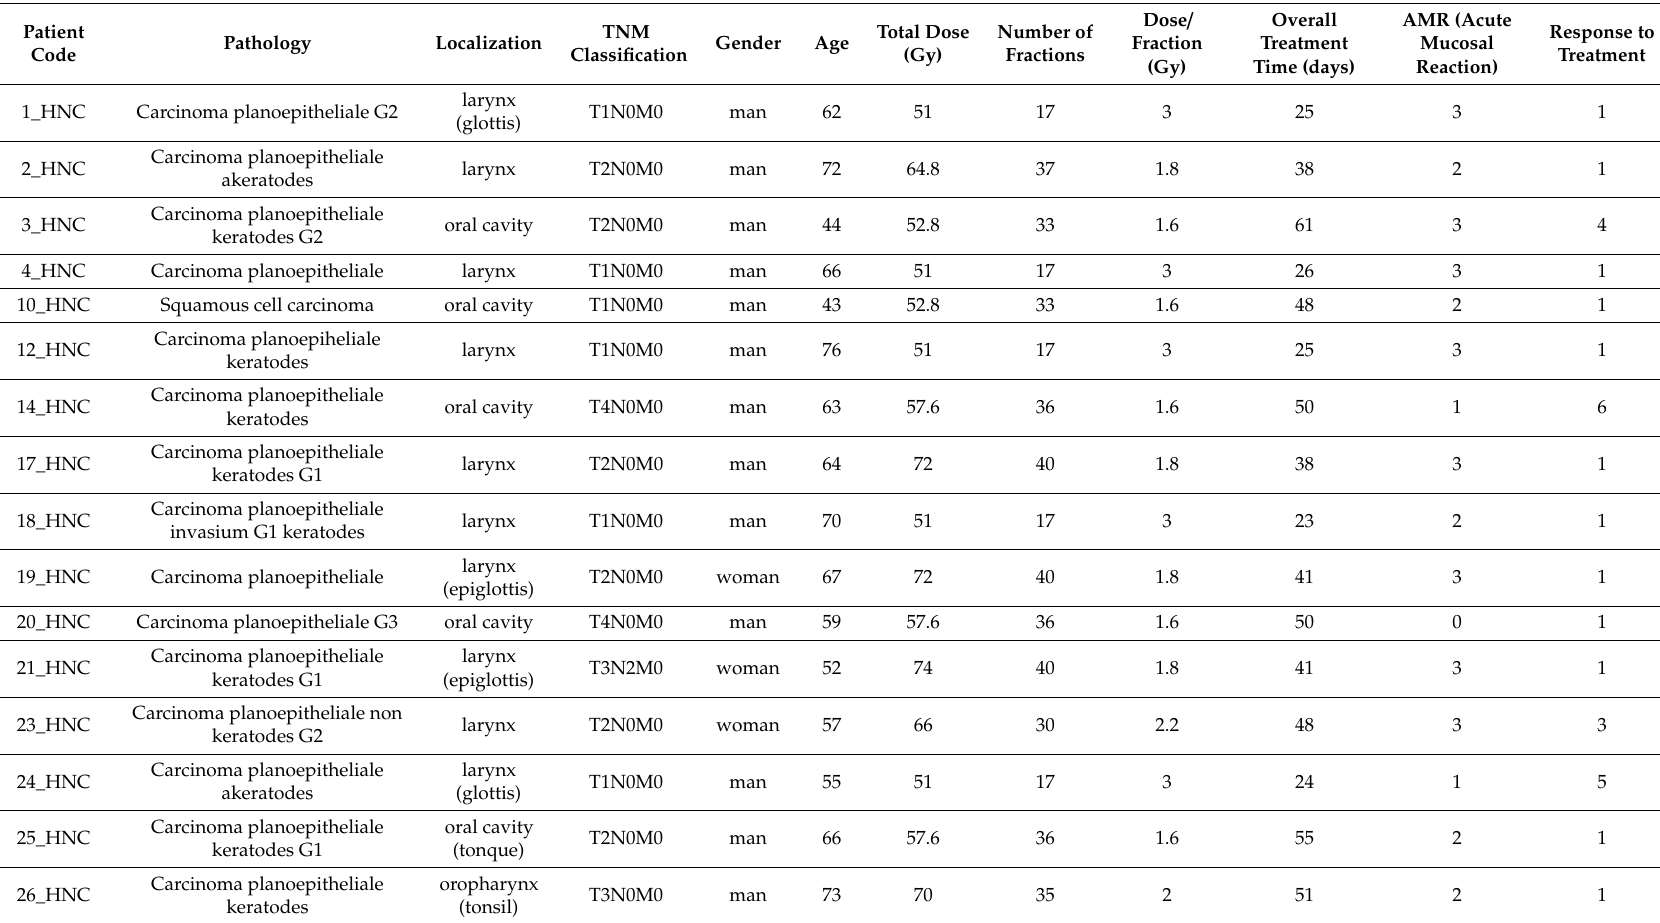
Table 1. Clinical parameters of head and neck squamous cell carcinoma